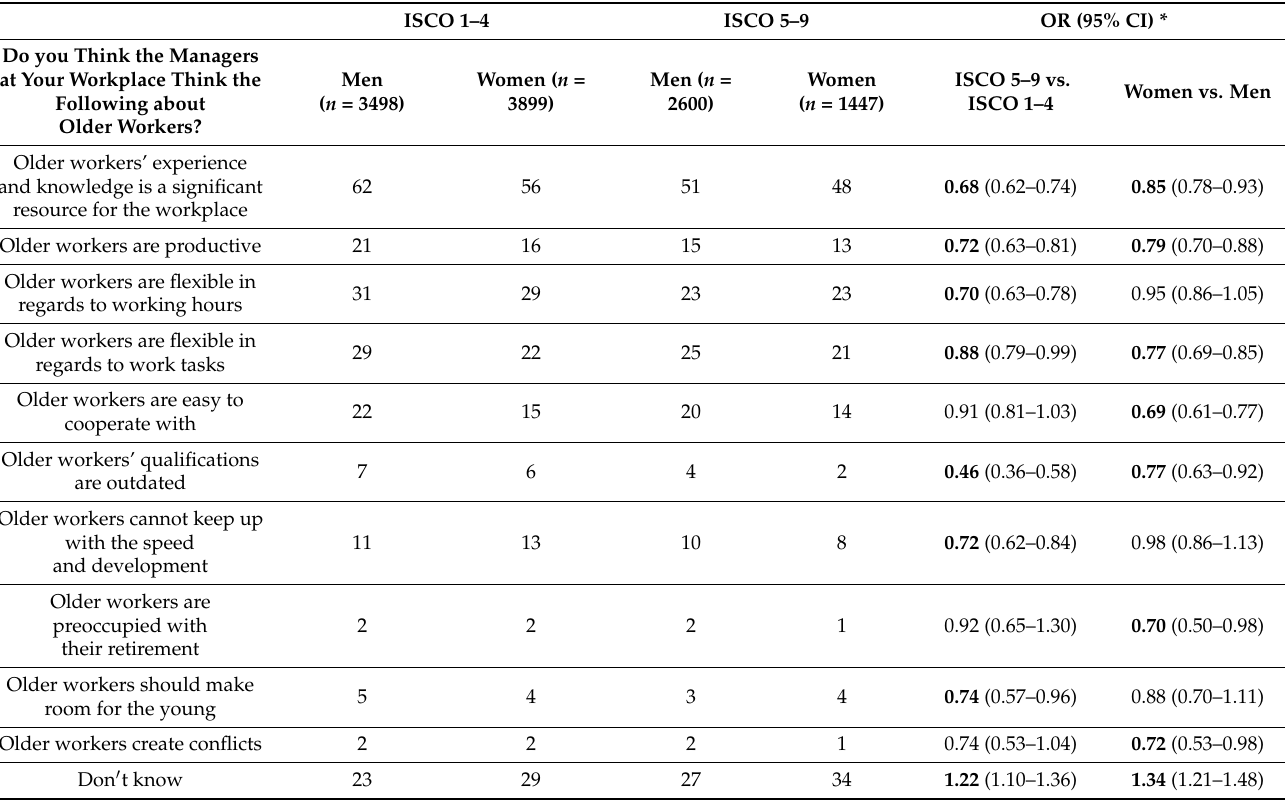
Table 1. Proportion of respondents (%) perceiving their managers to hold the respective attitudes towards older workers, divided by ISCO groups and gender as well as odds ratios between these groups.